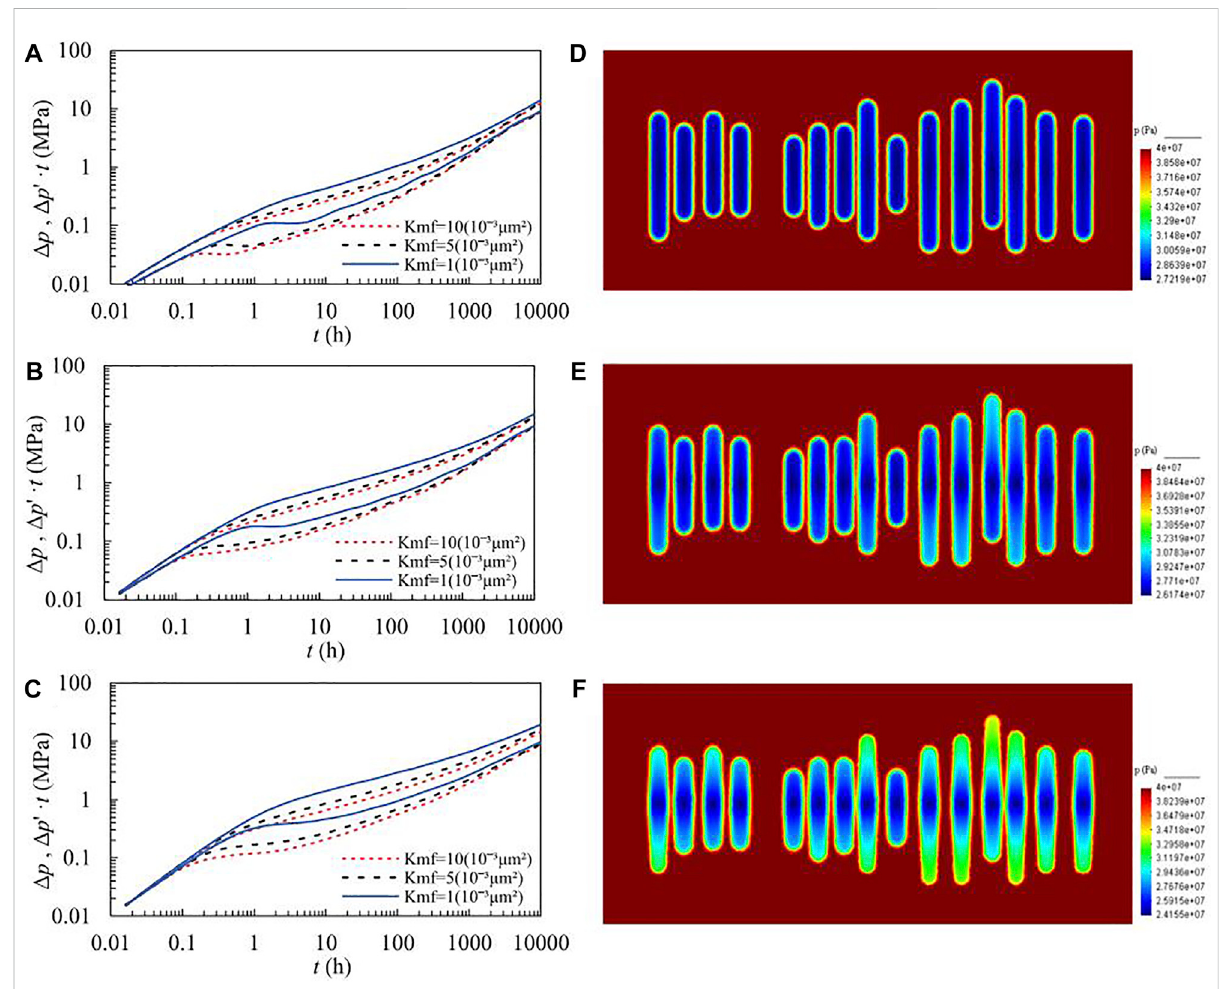
FIGURE 3 Log – logplotunderdifferent K mf conditionsandformationpressuredistribution. (A) K w =0.5 μ m 2 m; (B) K w =0.1 μ m 2 m; (C) K w =0.02 μ m 2 m; (D)